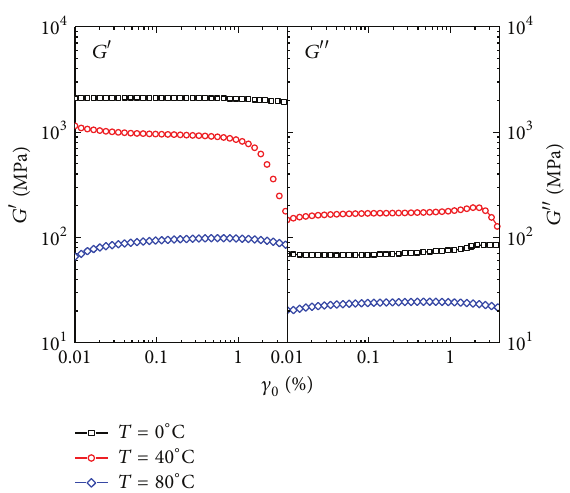
Figure 2: Amplitude sweep test at different temperatures. blue diamonds), the mechanical properties are determined by the soft segments. In this graph, the linear viscoelastic region can be identified as a pronounced plateau. For shear amplitudes within the range 0.03 % < 𝛾 < 1 %, the storage and loss moduli remain almost constant. This is a fairly broad LVR when compared to previously reported LVRs [29]. For shear amplitudes smaller than 0.03%, the decrease in the experimental signal-to-noise ratio results in an artificial deviation of moduli from the LVR